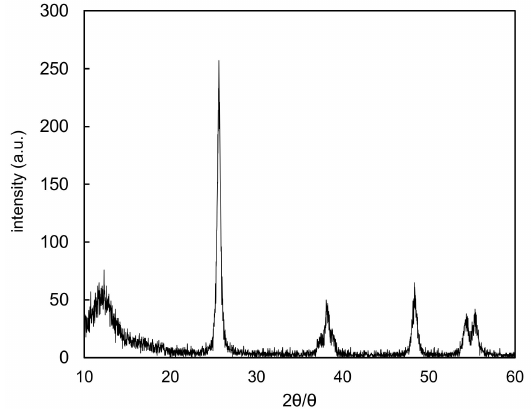
Figure 5. XRD pattern of the TiO 2 filter prepared in this